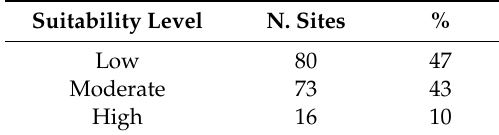
Table 1. Statistics of suitable sites for the deployment of a low cost stations network.